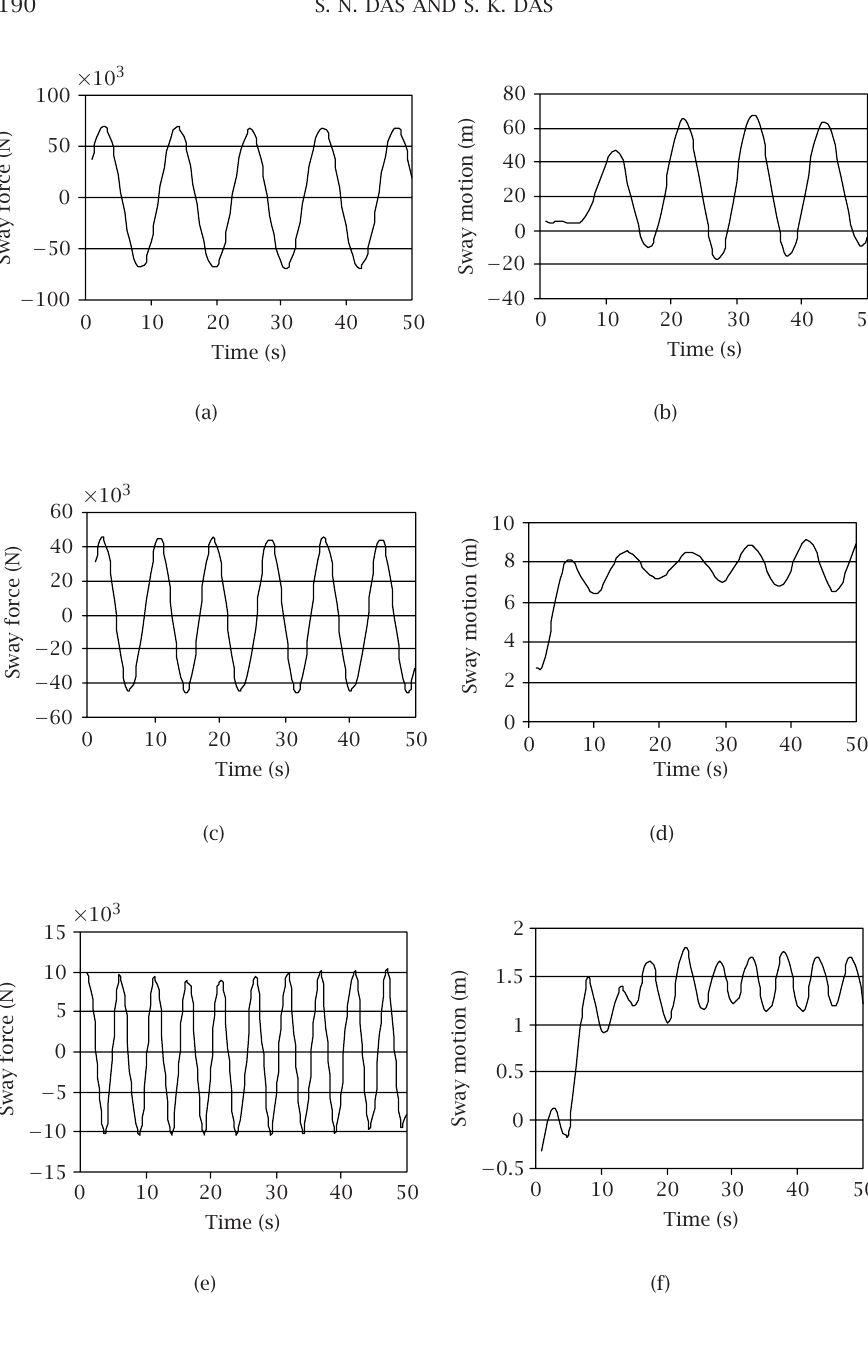
Figure 7.1 . (a, c, and e) Time history of forcing function and (b, d, and f) sway motion for wave frequencies (a, b) 0.56rad/s, (c, d) 0.74rad/s, and (e, f)